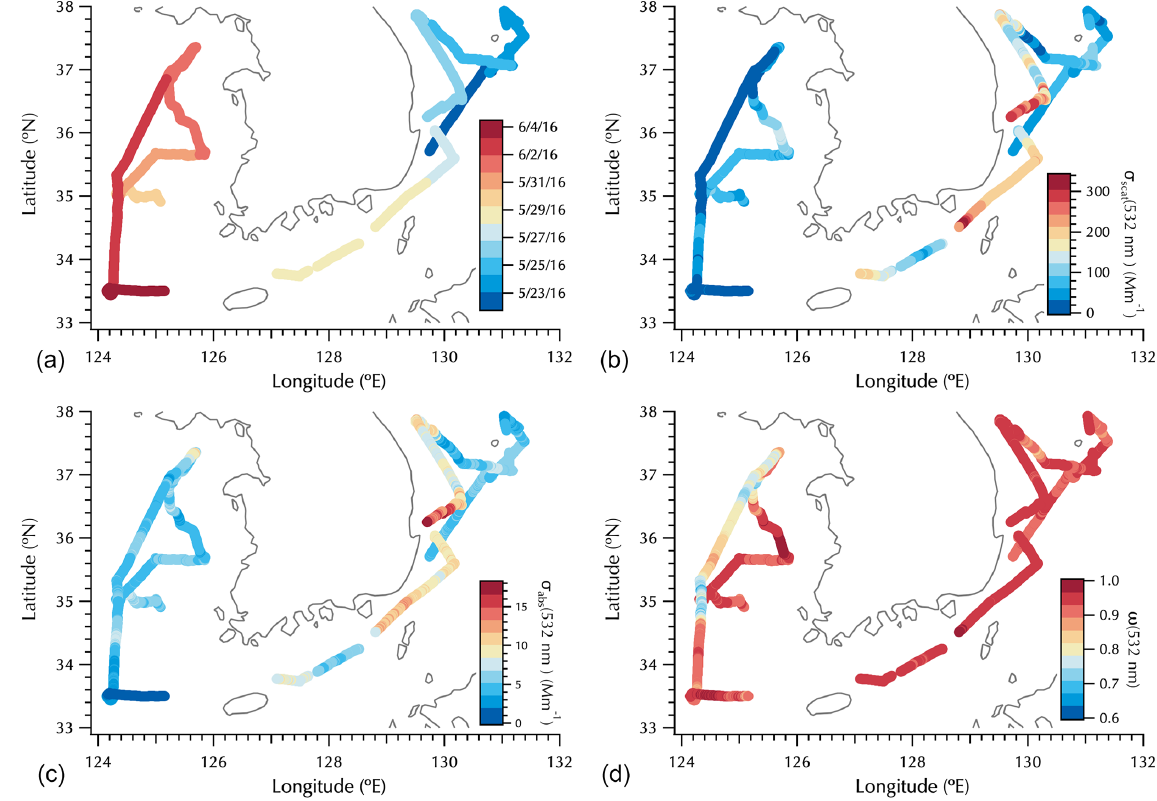
Figure 1. Cruise maps of date and time (KST, a ) with 532nm σ scat (Mm − 1 , b ), σ abs (Mm − 1 , c ), and ω (d) .